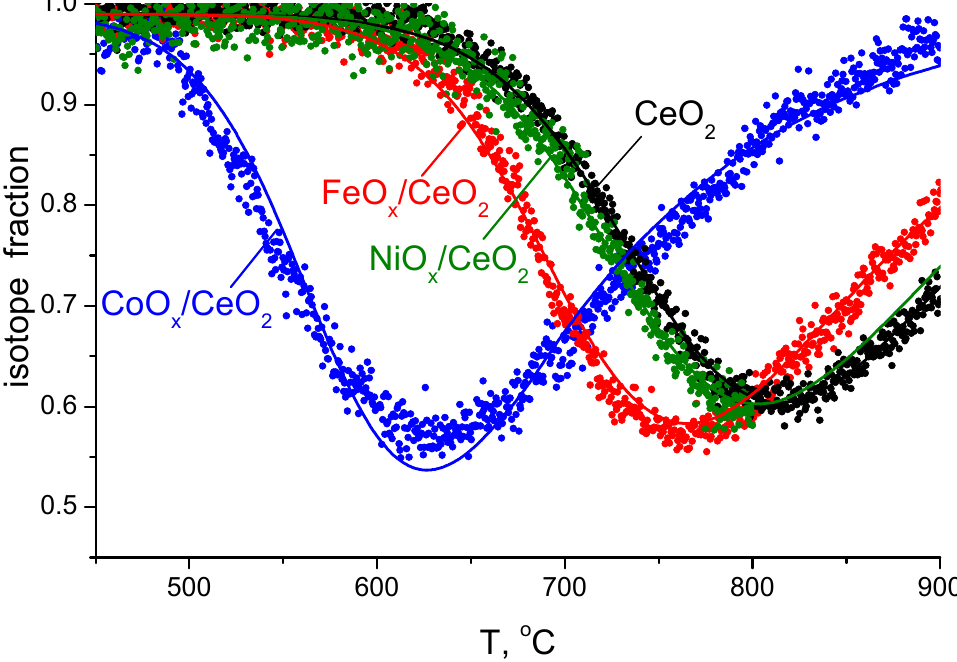
Figure 1. Change of 18 O fraction in O 2 during temperature-programmed isotope exchange in different CeO 2 -based catalyst samples. Me = 0.86–0.91 wt.%. Points—experiment, lines—calculation. At the same time, a principally different distribution of labeled O 2 molecules was observed during TPIE (Figure 2). So, in CeO 2 , NiO x /CeO 2 , and FeO x /CeO 2 samples, 16 O 2 appears in the gas phase first, and its fraction in O 2 ( f 32 ) exceeds that of 16 O 18 O ( f 34 ) for a long period of time. In the CoO x /CeO 2 sample, on the contrary, 16 O 18 O appear first, and f 34 is higher than f 32 for all period of monitoring. Klier and Muzykantov [21,28] proposed the theory of isotope exchange of oxygen with solid oxides, which is currently widely used